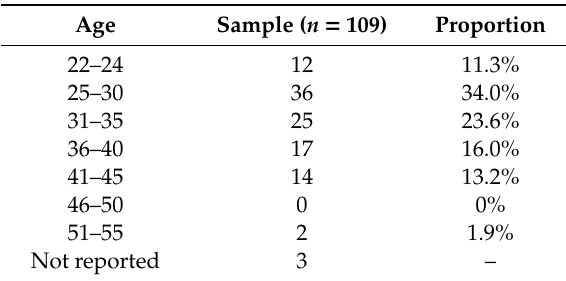
Table 1. Age distribution of sample for Study